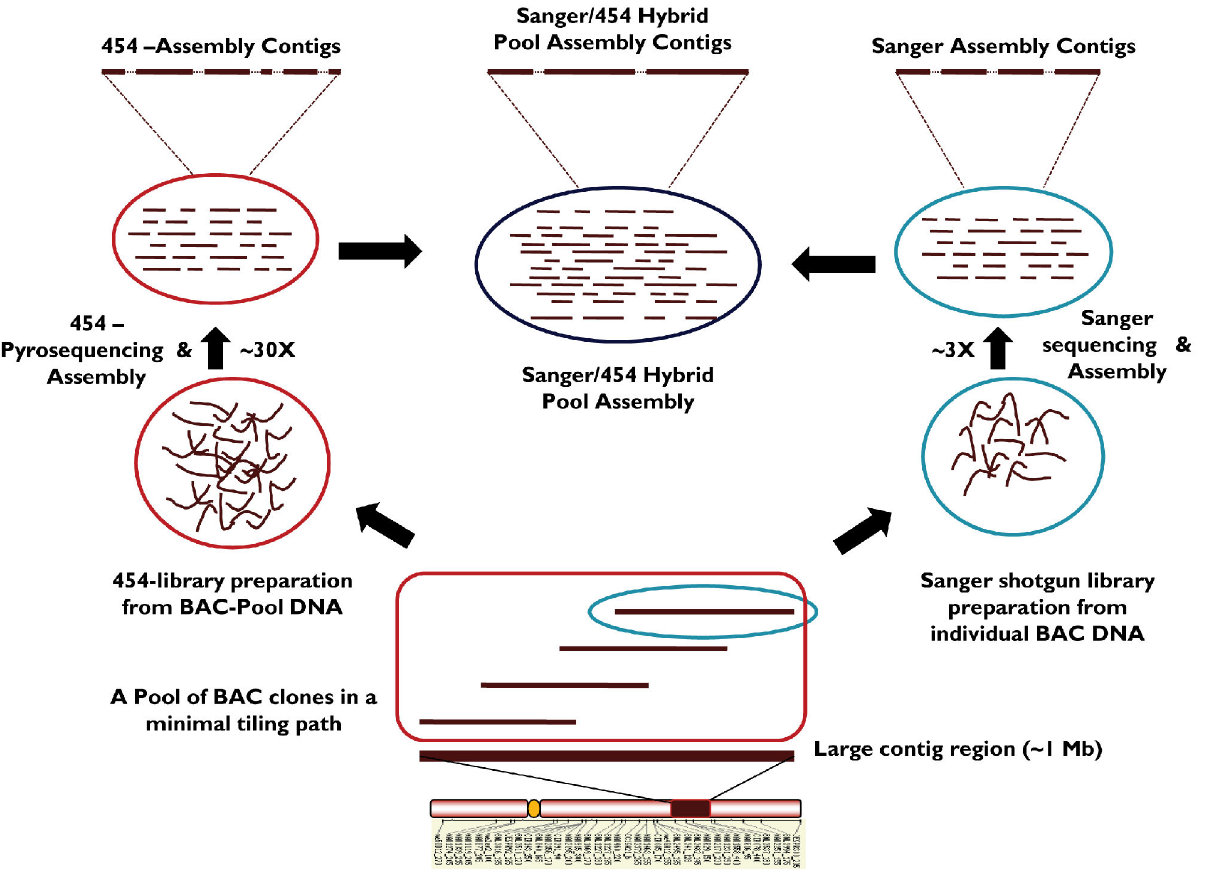
Figure 1. A schematic diagram representing MTP based BAC-pool sequencing for complex genomes. 454 and Sanger hybrid sequencing approach was used to derive high quality sequence assemblies in allotetraploid cotton. doi: